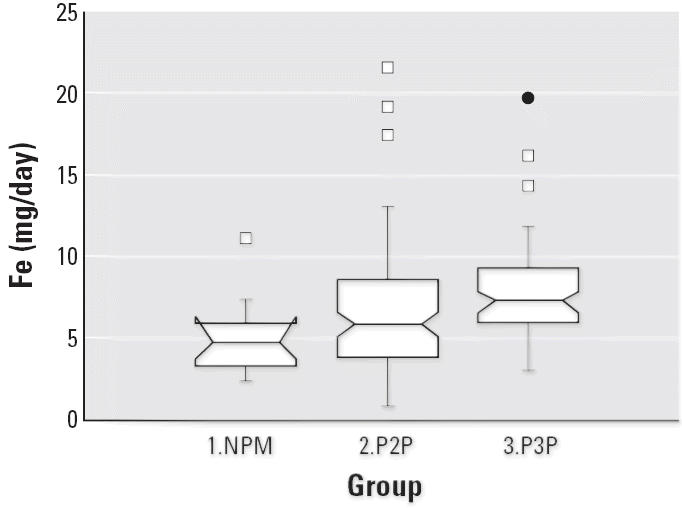
Notched box plot for descriptive statistical data showing daily intakes
of Fe from 6-day duplicate diets. The recommended daily intake for such
females is 15 mg Fe (National Research Council 1989).